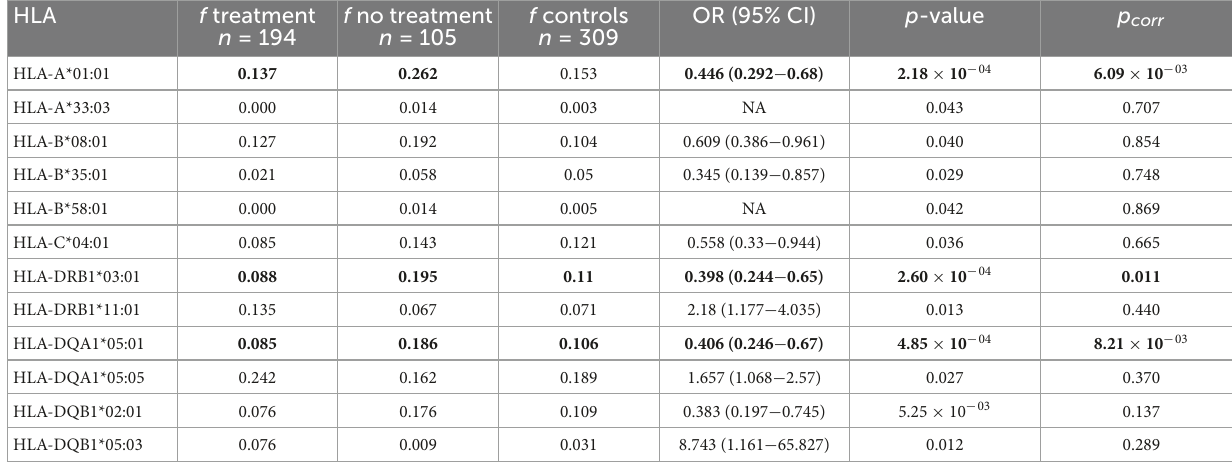
TABLE 6 Comparison of the HLA allele frequencies between the patients with treatment ( n = 194) compared with the patients without treatment ( n = 105); only the alleles associated at least on the primary level are shown. HLA f treatment f no treatment f controls n = 194 n = 105 n =